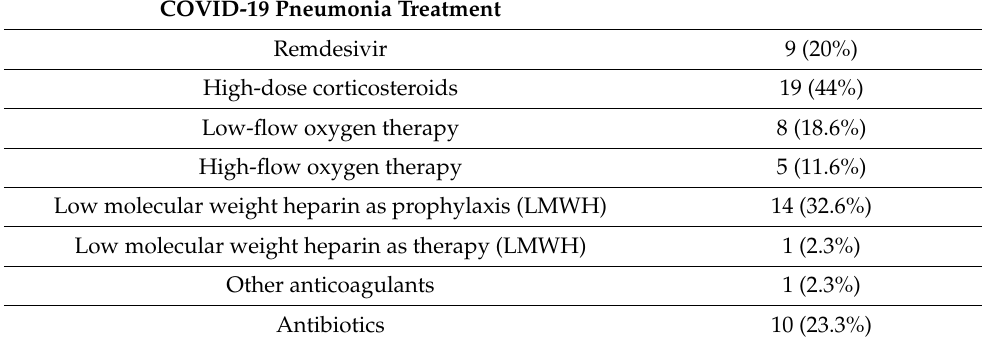
Table 4. COVID-19 pneumonia